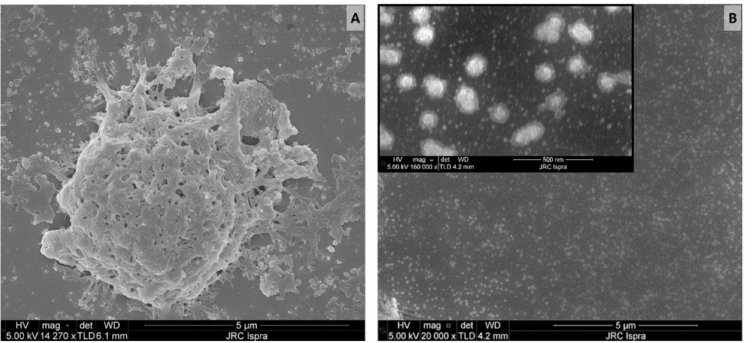
Figure 2. SEM images of teabag leachates prepared on different silicon substrates: ( A ) untreated Si ( B ) hydrophobically modified Si-PTFE-PDDA supports. Scale bar: 5 µ m (500 nm for the insert in